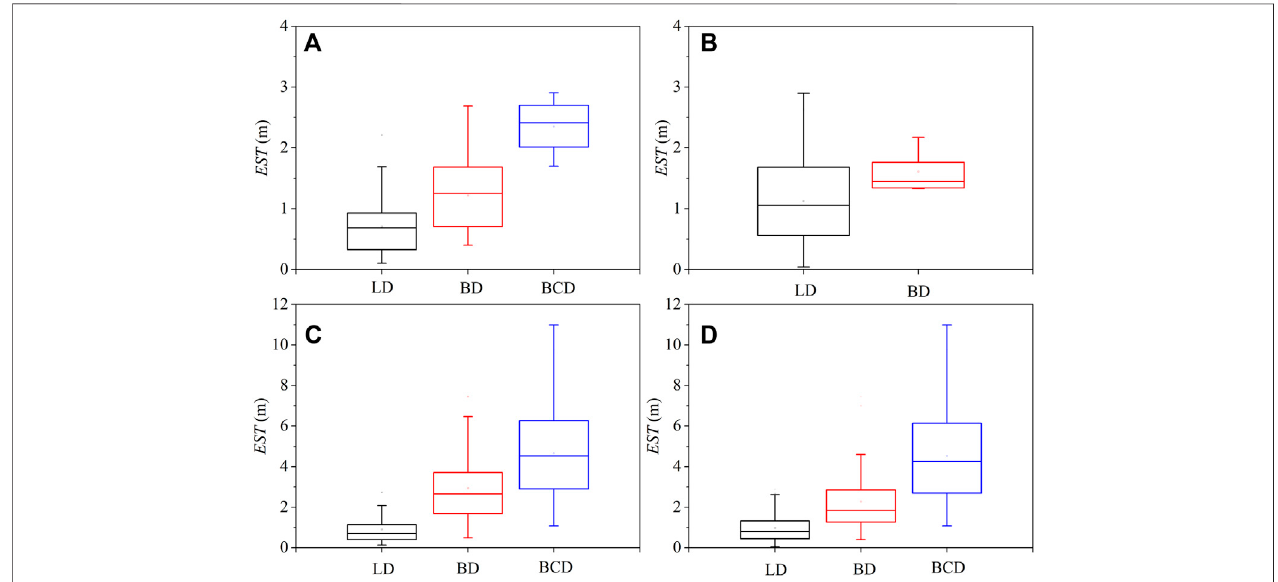
FIGURE 12 | Distribution characteristics of EST for area A1 (A) , A2 (B) , A3 (C) , and all three areas (D) . LD, linear dunes; BD, barchan dunes; BCD, barchan chain dunes.